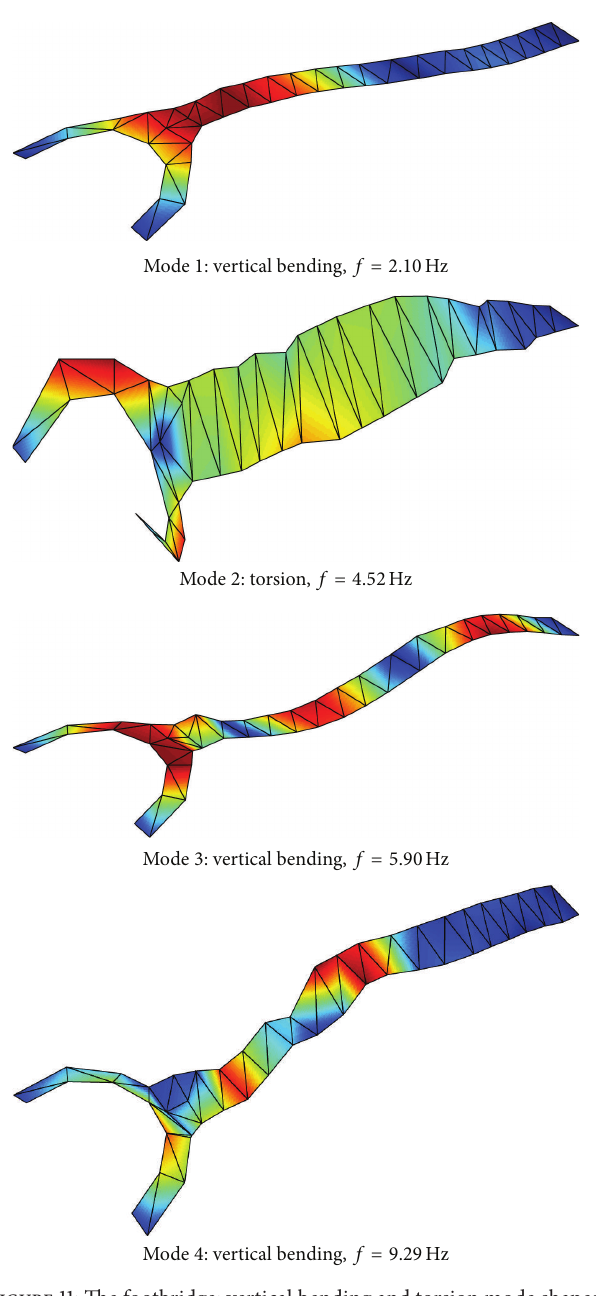
Figure 11: The footbridge: vertical bending and torsion mode